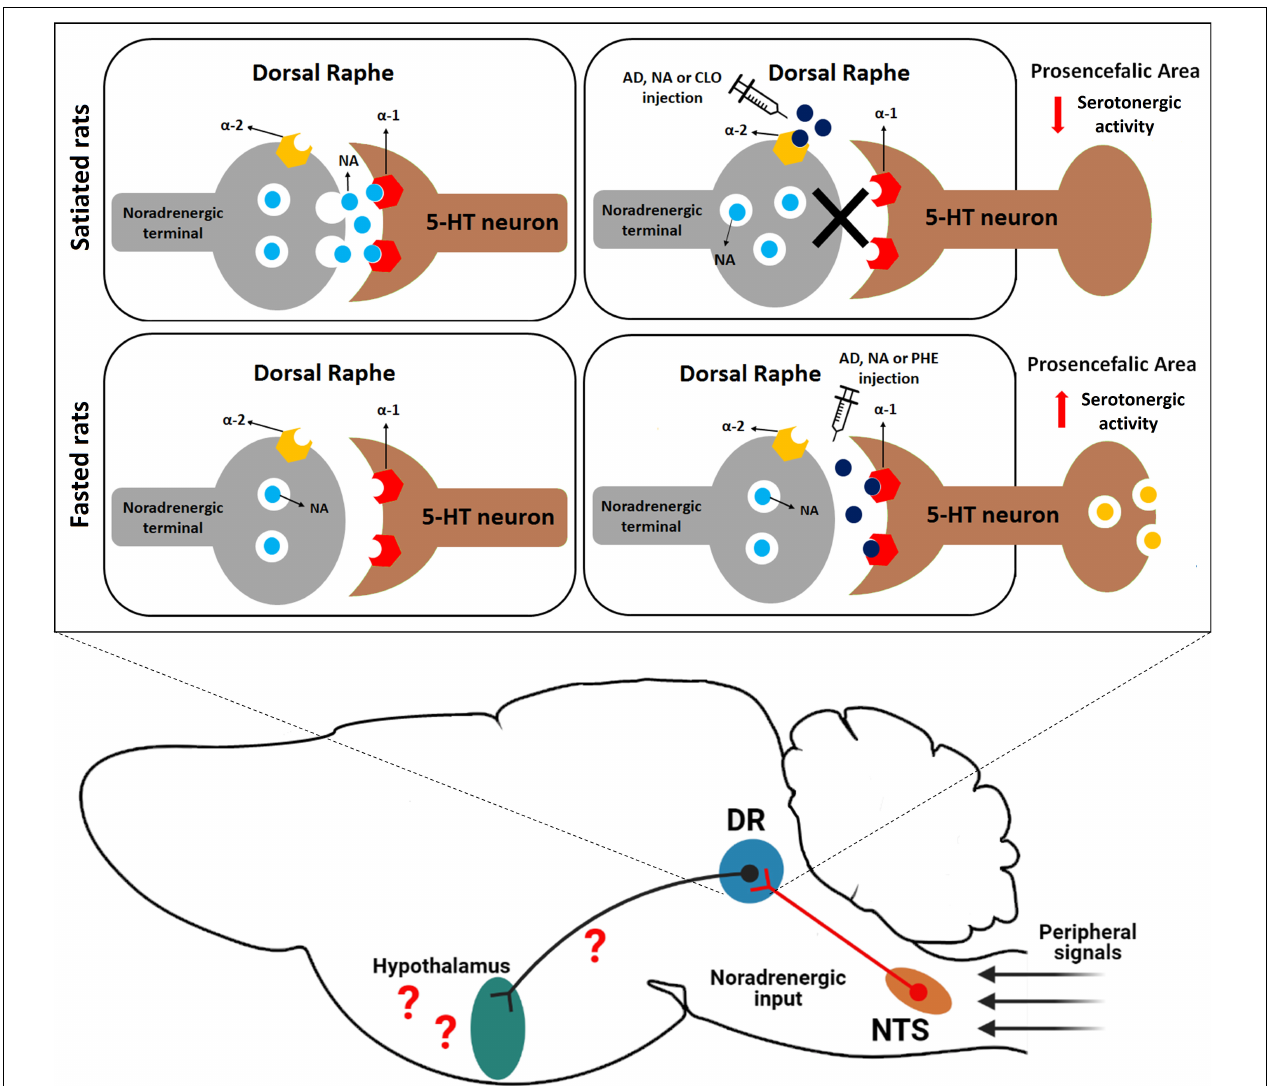
FIGURE 4 | Proposed role of noradrenergic circuits in the DR in food intake regulation in rats. In the fed state, there is a tonic activation of α -1 adrenoceptors into this nucleus, which facilitates the release of a signal that inhibits food intake (possibly via 5-HT release into proensephalic areas) into prosencephalic areas. On the other hand, in fasted rats the intensity of this endogenous noradrenergic activity seems to decline. We also speculate that peripheral satiety signals, such as CCK, could indirectly modify neuronal activity in the DR through noradrenergic neurons located in the NTS that send neuronal input to DR neurons. DR, dorsal raphe nucleus; NTS, nucleus of the solitary tract; AD, adrenaline; NA, noradrenaline; CLO, clonidine; PHE,